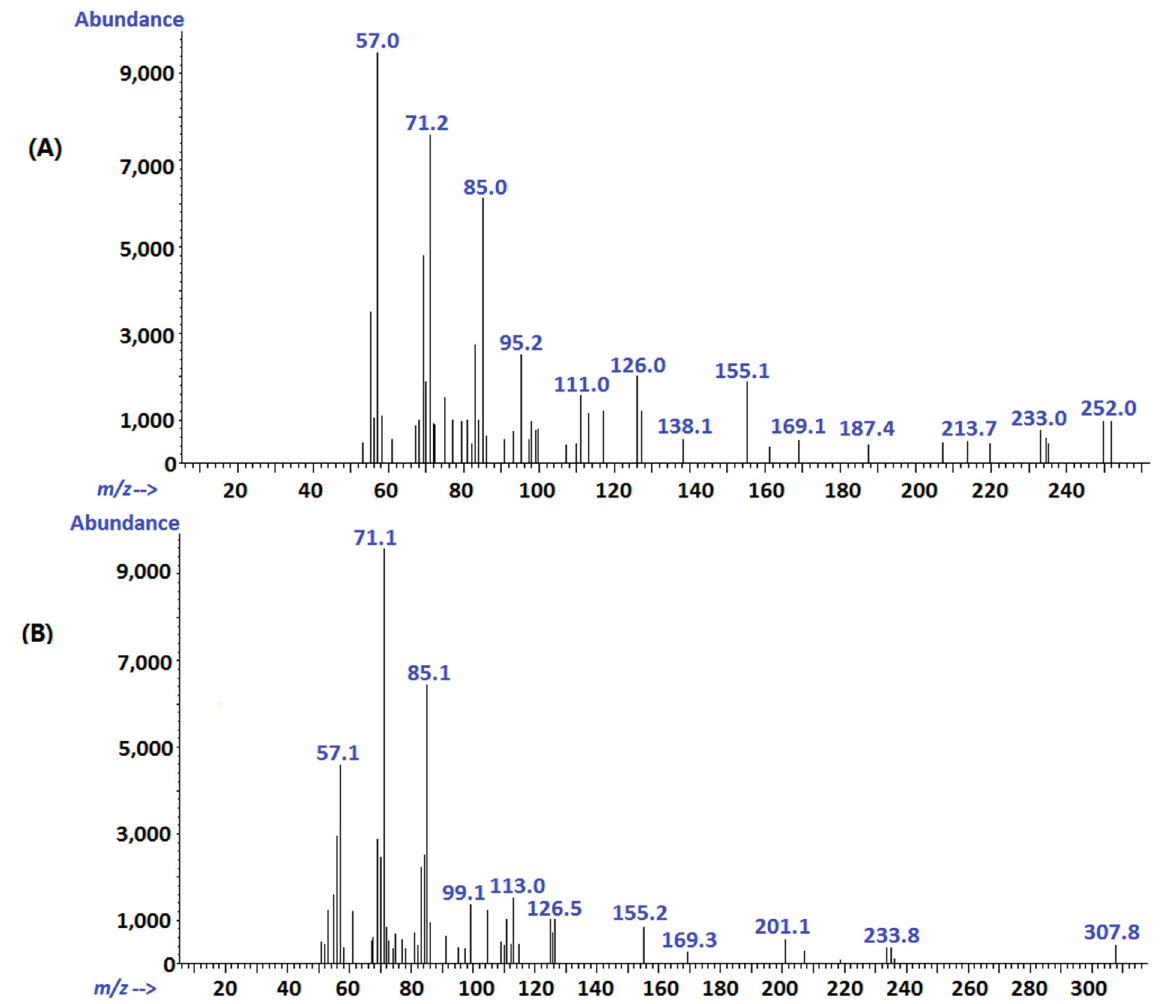
Figure 8. MS fragment ions of 2-undecanone ( A ) and decanoyl acetaldehyde ( B